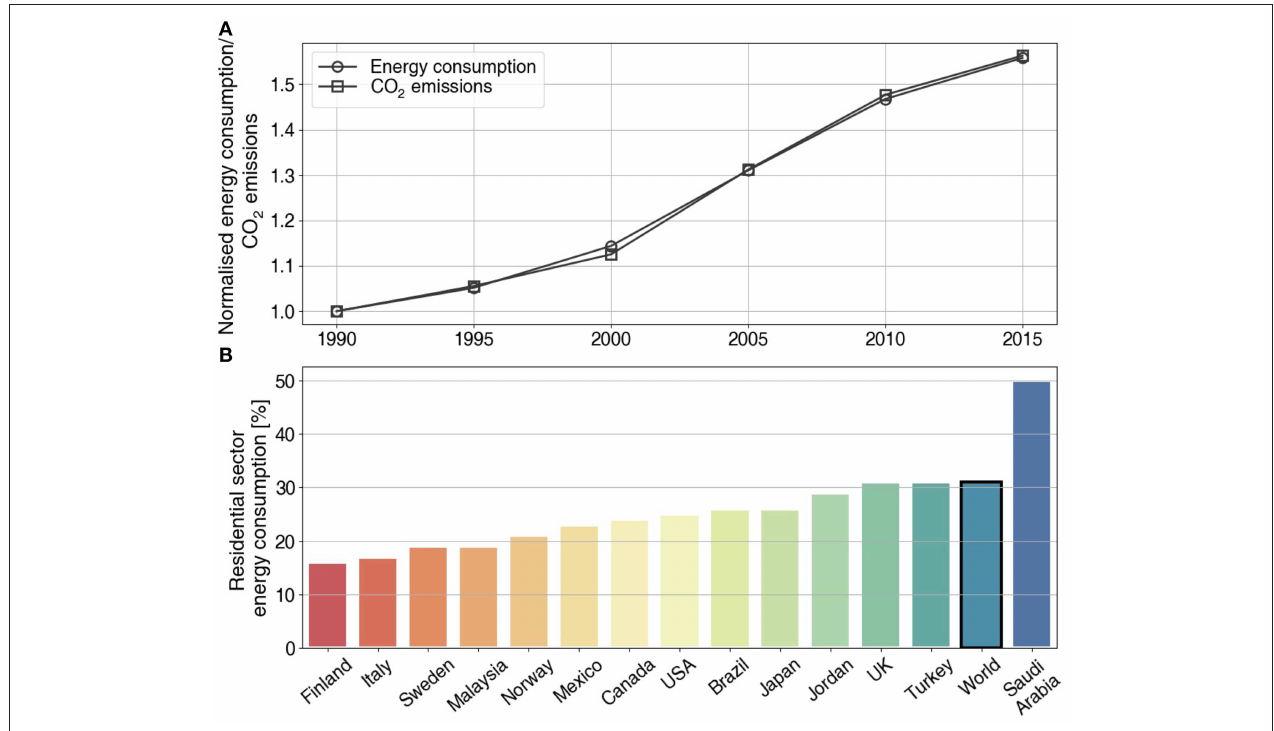
FIGURE 1 | World energy consumption and CO 2 emissions, normalized to 1990 (International energy agency, 2018) (A) , Residential sector energy consumption by country (B)